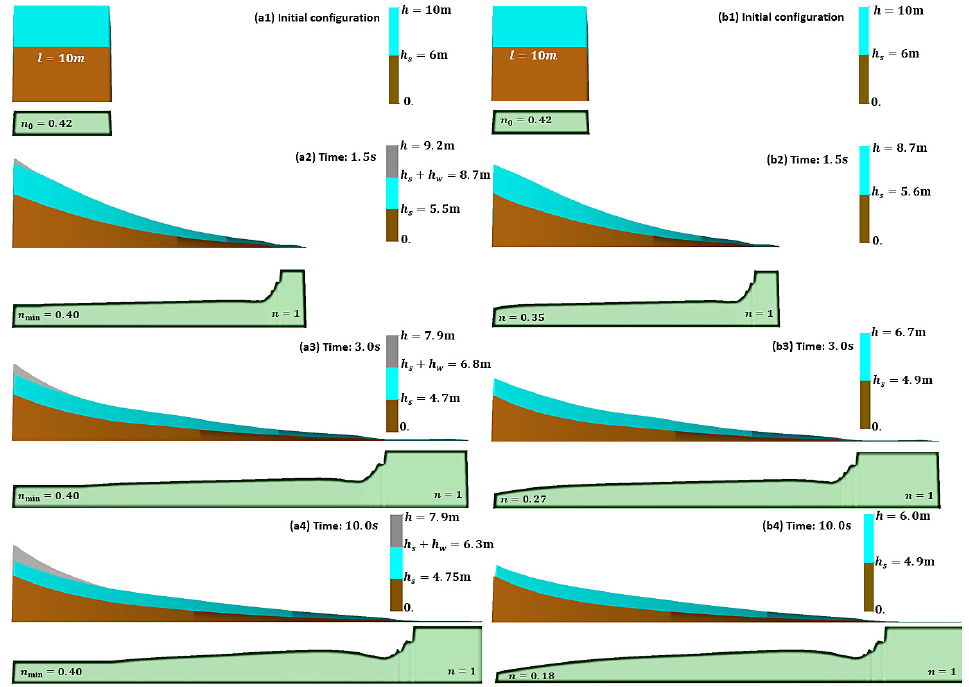
Figure 5. The profiles of the propagation heights and their corresponding porosity of dam break simulations performed through ( a ) the new and ( b ) the previous model [20], at times 0, 1.5, 3, and 10